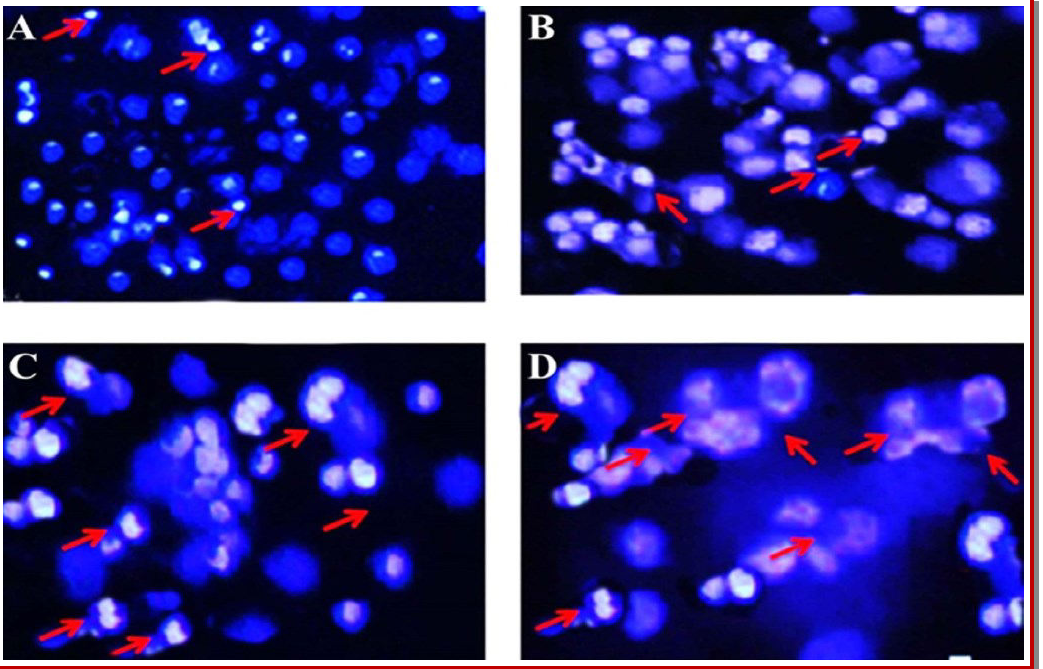
Figure 3: Fluorescence microscopy after MCF-7 cells were treated with different concentration (30, 90 and 120 µM) of bergaptol for 48 hours and stained with DAPI and analysed for nuclear condensation. Data are representative of one of the three independ- ent experiments. A, represents the taxol-treated cells, while as B, C and D represent 30, 90 and 120 µM of bergaptol